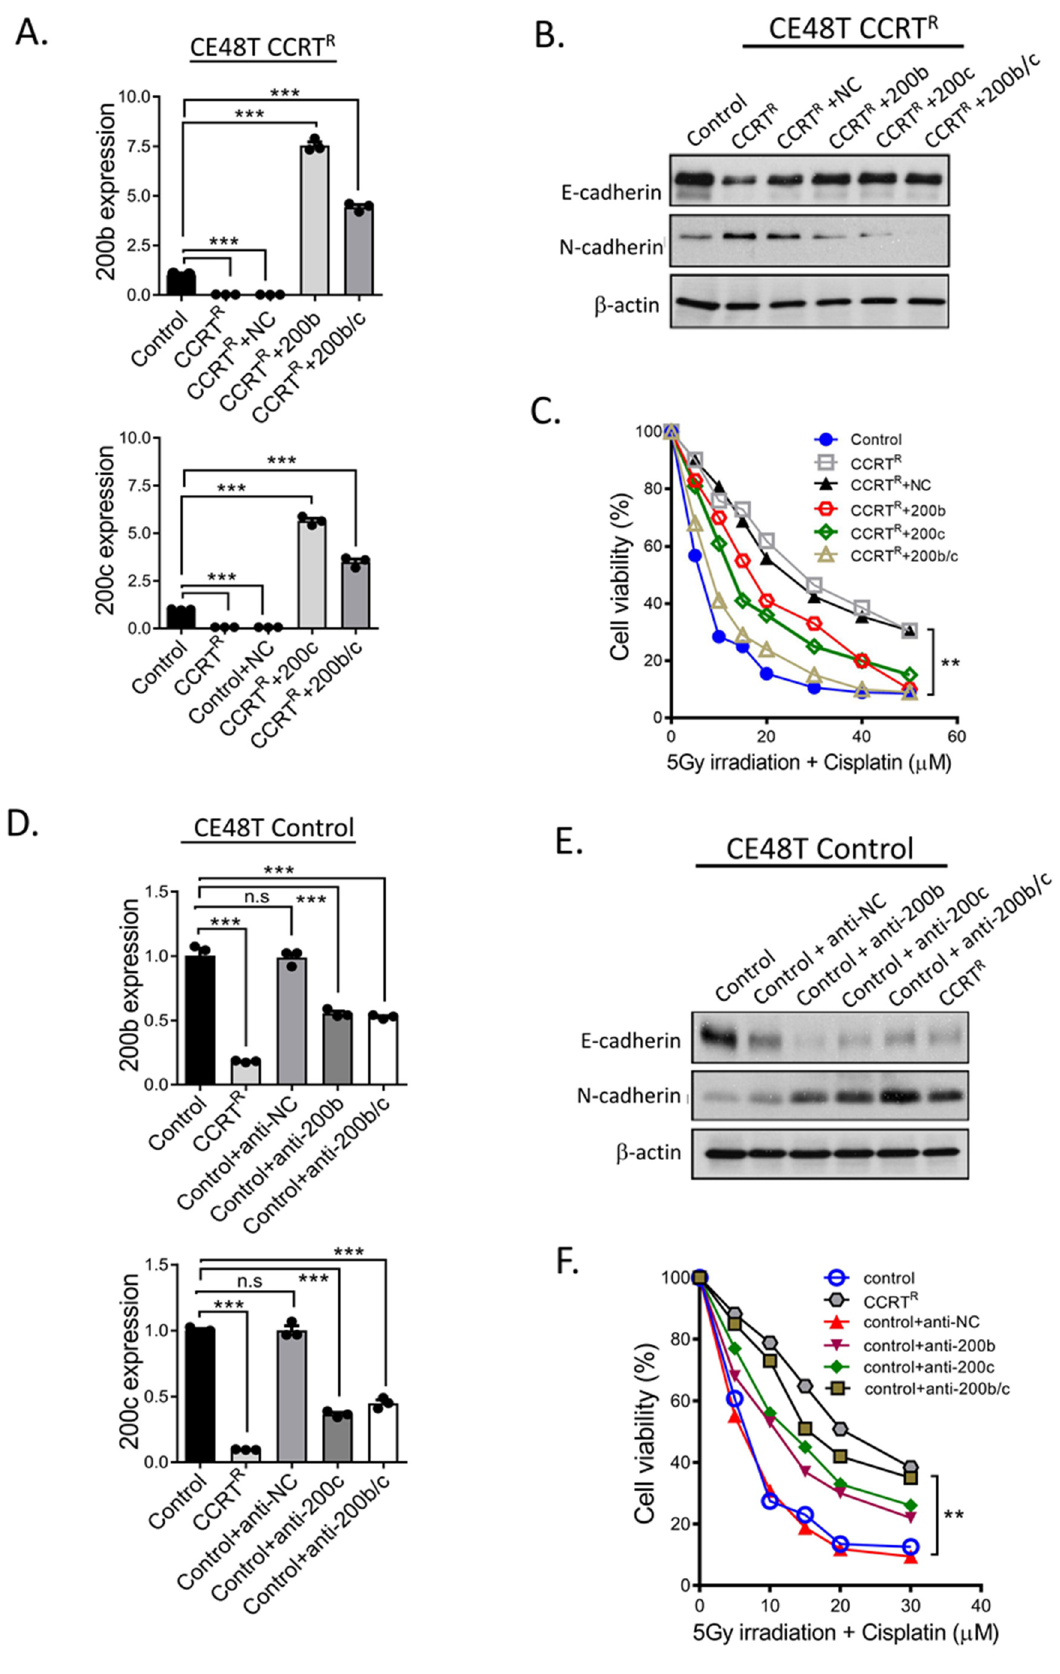
Figure 3. The role of miR-200b and miR-200c-mediated CCRT responses in CE48T cells. ( A ) Exogenous control miRNA, miR-200b, miR-200c, and miR-200b/c precursors were transfected into CE48T CCRT